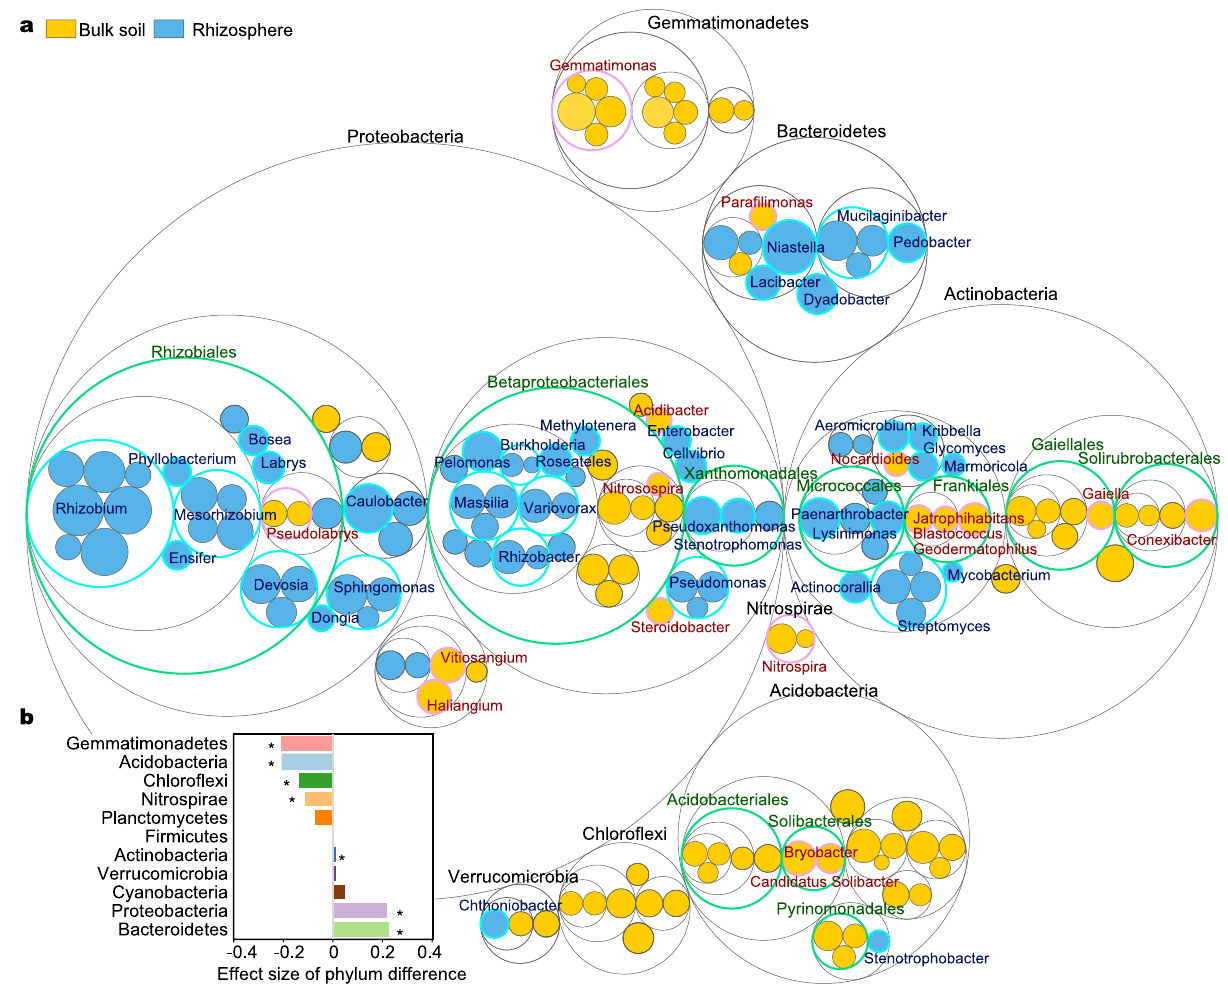
Fig. 2 Differences in relative abundance of bacterial taxa between the rhizosphere and bulk soil. a Difference at the amplicon sequence variants (ASV) level. Blue and yellow bubbles represent ASVs with signi fi cant enrichment (FDR < 0.05) in rhizosphere and bulk soil, respectively, based on statistical analysis with ALDEx2. Bubble sizes represent the ALDEx2 effect size between the relative abundance of ASV in the rhizosphere and in the bulk soils. The largest circles in black represent the phylum level, and the innermost circles in green represent the order level. All ASVs that can be annotated at genus level were marked next to the corresponding bubbles. b Differences at phylum level. Positive values indicate higher relative abundance of the phylum in rhizosphere, while negative values indicate higher relative abundance of the phylum in the bulk soil. The differences were statistically analyzed using ALDEx2. An asterisk (*) indicates a signi fi cant difference with FDR < 0.05 based on statistical analysis with ALDEx2. Source data are provided as a